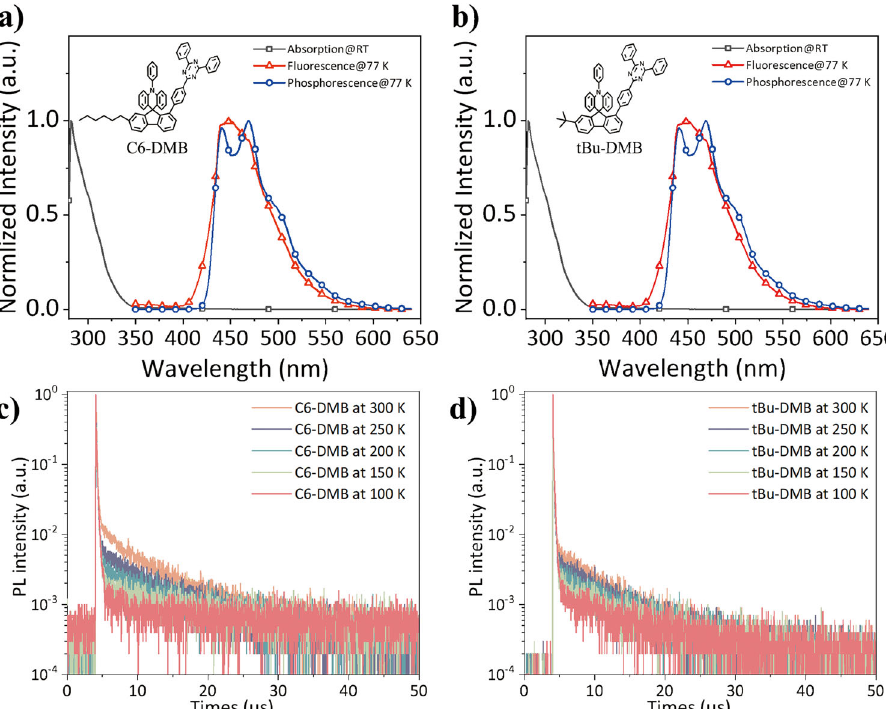
Fig. 4 Photophysical properties. UV – vis absorption spectra, fl uorescence, and phosphorescence spectra at 77 K of ( a ) C6-DMB and ( b ) tBu-DMB . Temperature-dependent transient PL decay characteristics of ( c ) C6-DMB and ( d ) tBu-DMB in doped (30 wt%) mCP fi